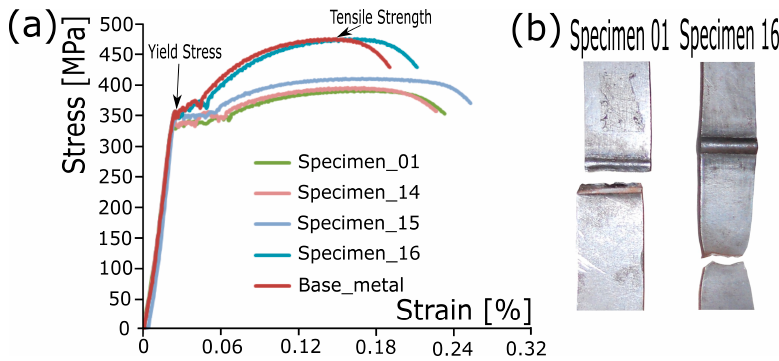
Figure 5. ( a ) Yield stress and tensile strength according to the ISO 5178 Standard Test Method. ( b ) Specimens after they were tested according to ISO 5178.